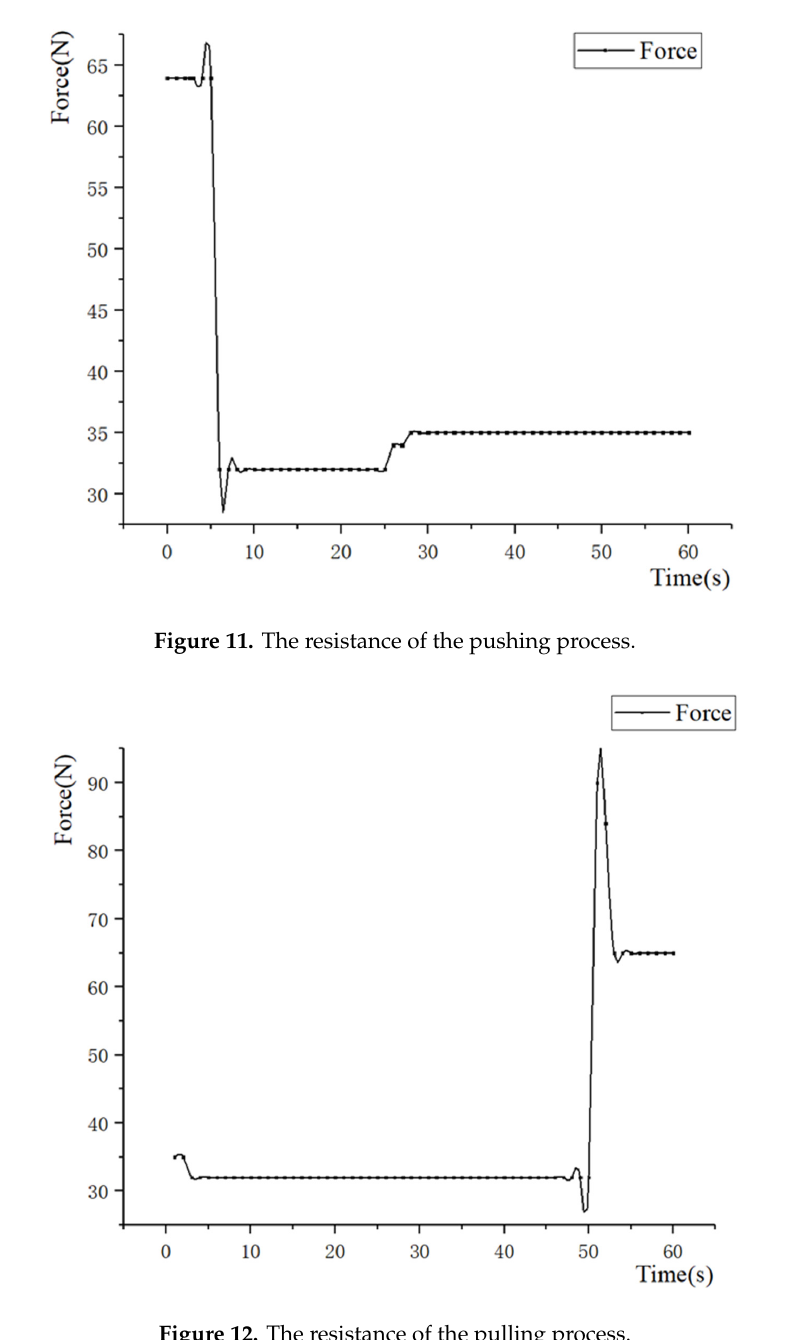
Figure 12. The resistance of the pulling process.